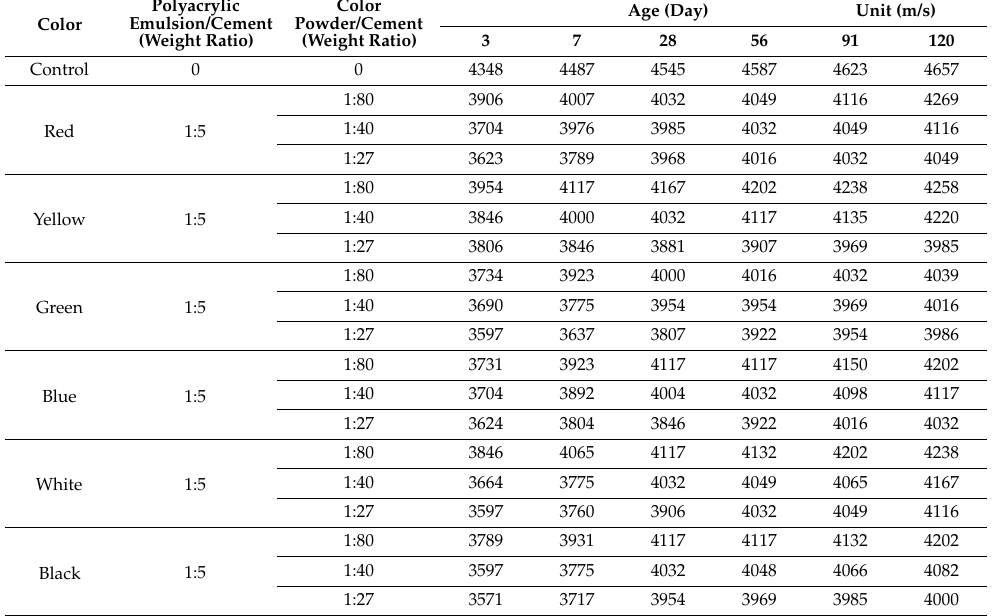
Figure 10. Flexural strength of mortar at W/C = 0.6 and under saturated limewater curing when weight ratios of color powder/cement at 1:80, 1:40, and 1:27 are added. Table 4. UPV of colored mortar at W/C = 0.5 and under limewater curing when weight ratios of color powder/cement at 1:80, 1:40, and 1:27 are